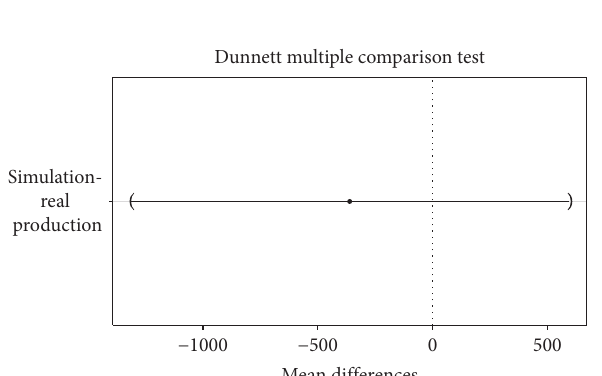
Figure 6: Fixed values test.